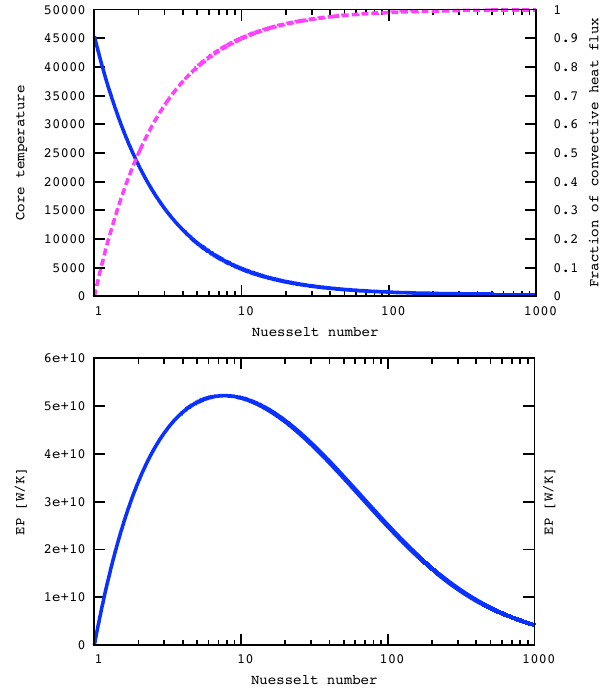
Fig. 5. Top plot: core temperature and fraction of convective heat flux with varying Nusselt number. The Nusselt number is a dimen- sionless value of the proportion of convection to conduction. Core temperature is plotted with a solid line (units on left vertical axis). Fraction of convective heat flux is plotted with a dashed line (units on right vertical axis). Bottom plot: Entropy production via mantle convection with varying Nusselt number.